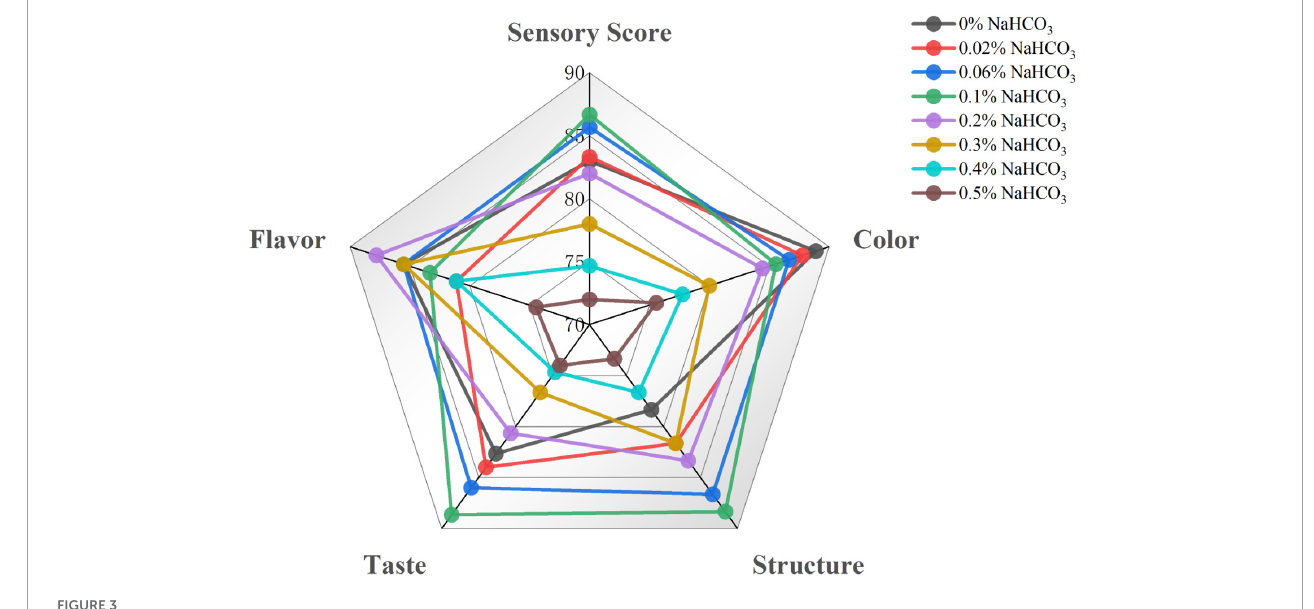
FIGURE3 Effect of sodium bicarbonate on the sensory evaluation of semi-dried rice noodles.